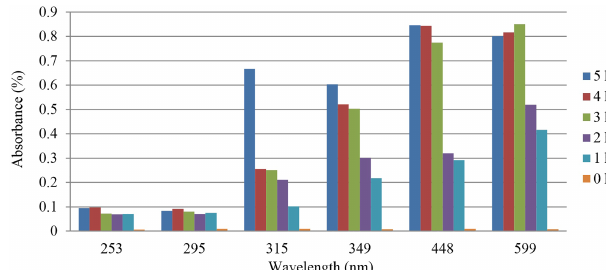
Figure 3. UV–visible spectra of Er 2 O 3 nanoparticles without SL.